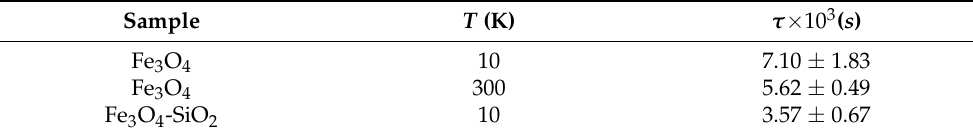
Table 2. The magnetic relaxation time of Fe 3 O 4 and Fe 3 O 4 -SiO 2 nanoparticles.